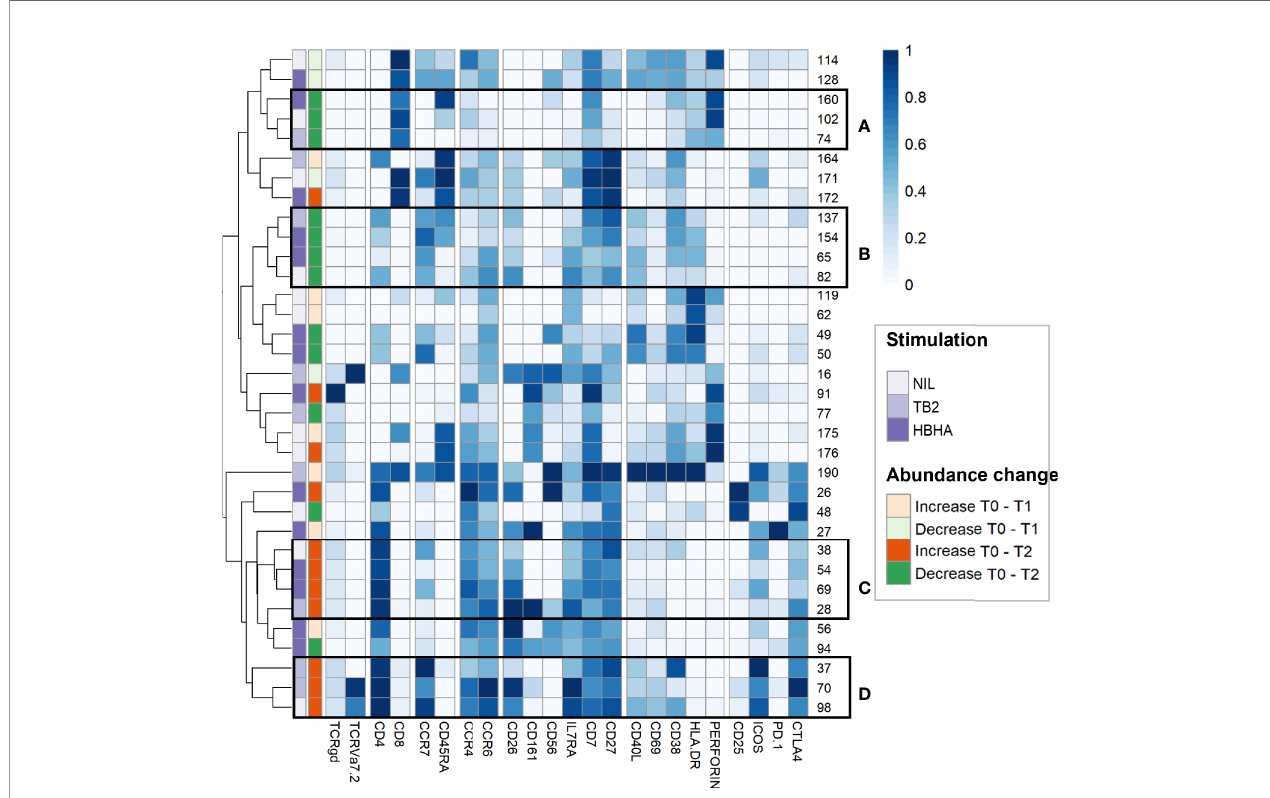
FIGURE 4 | In-depth phenotyping shows differential involvement of effector and memory T-cells in cluster abundance changes during TB treatment. Mean marker expression levels were visualized using heatmapping for cell cluster which increased (orange color code) or decreased (green color code) throughout treatment. Each line represents one cell cluster. Scales indicate normalized mass signal intensity. Hierarchical clustering was performed based on marker expression levels, regrouping cell clusters of similar immunophenotypes. Black rectangles annotated from (A – D) indicate cell cluster subgroups with both similar abundance changes and similar immunophenotypes (i.e. at least same main T-cell